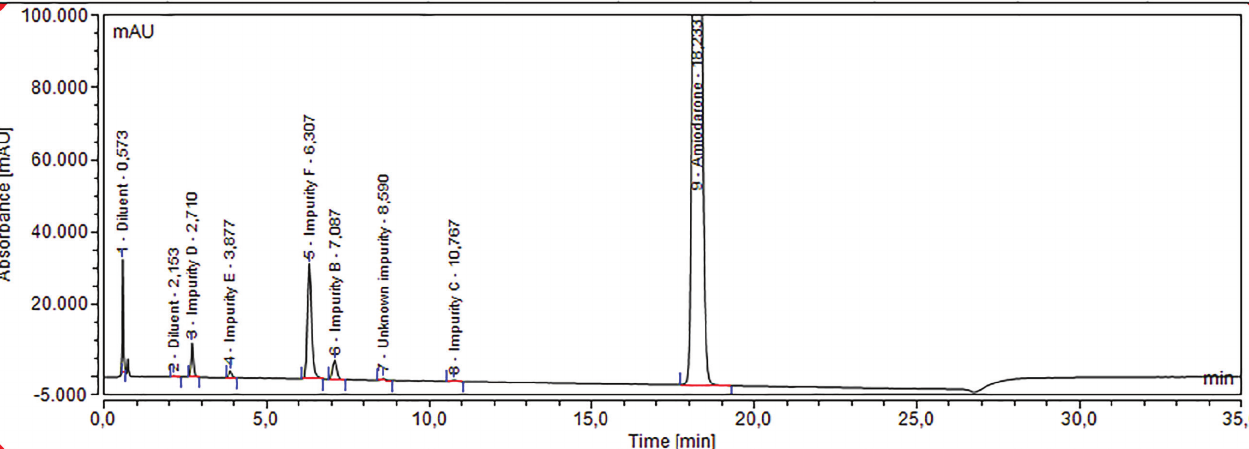
FIGURE 5 - Representative chromatogram of amiodarone hydrochloride tablets after degradation by dry heat